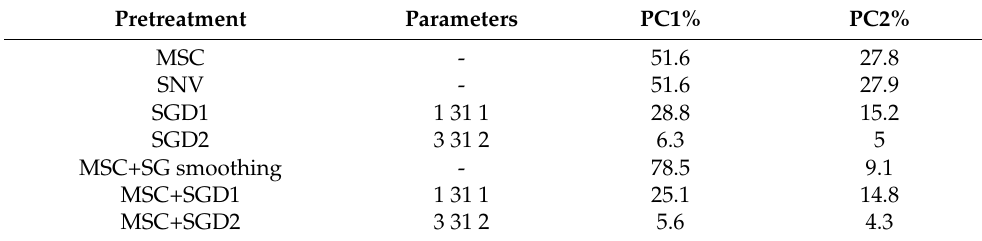
Table 1. PCA analysis results of spectra with different pre-processing